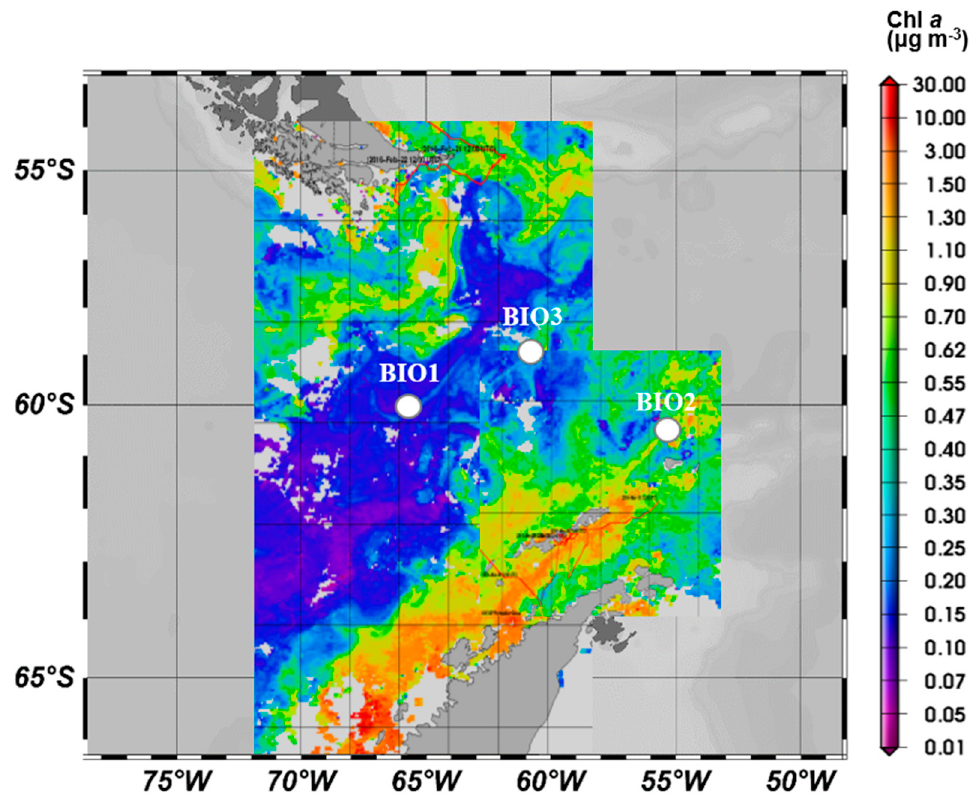
Figure 1. Study sites (Bio 1, 2 and 3) overlaid on the satellite-based chlorophyll a map. Mean chlorophyll concentrations (mg m − 3 ) during March 2016 derived from the satellite MERIS Polymer product.